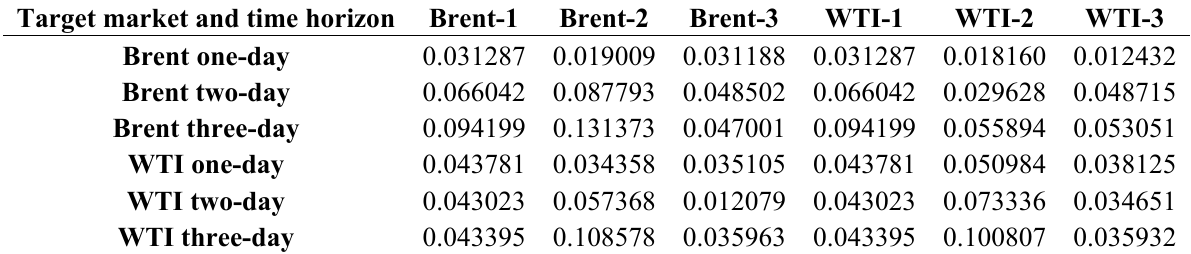
Table 10. Standard deviation of Coefficients of MKR for one-day, two-day, and three-day ahead predictions (14 experiments for each time horizon).